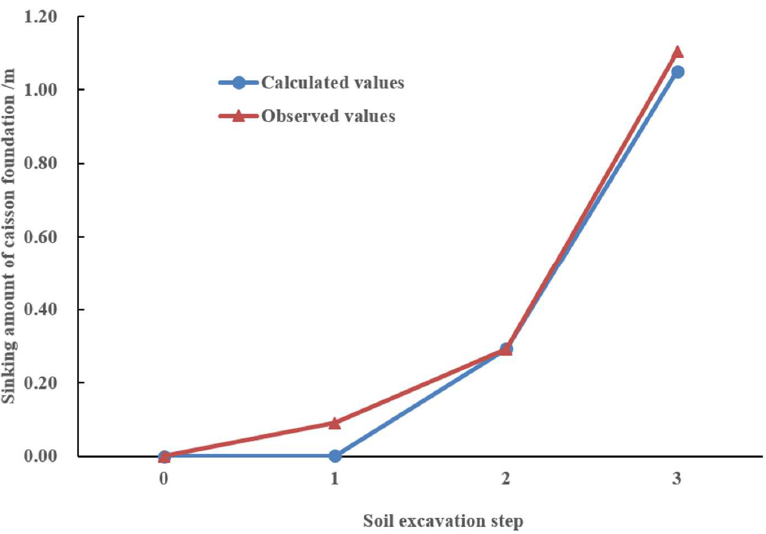
Figure 15. Sinking amount comparison between numerical results and the field measurements.